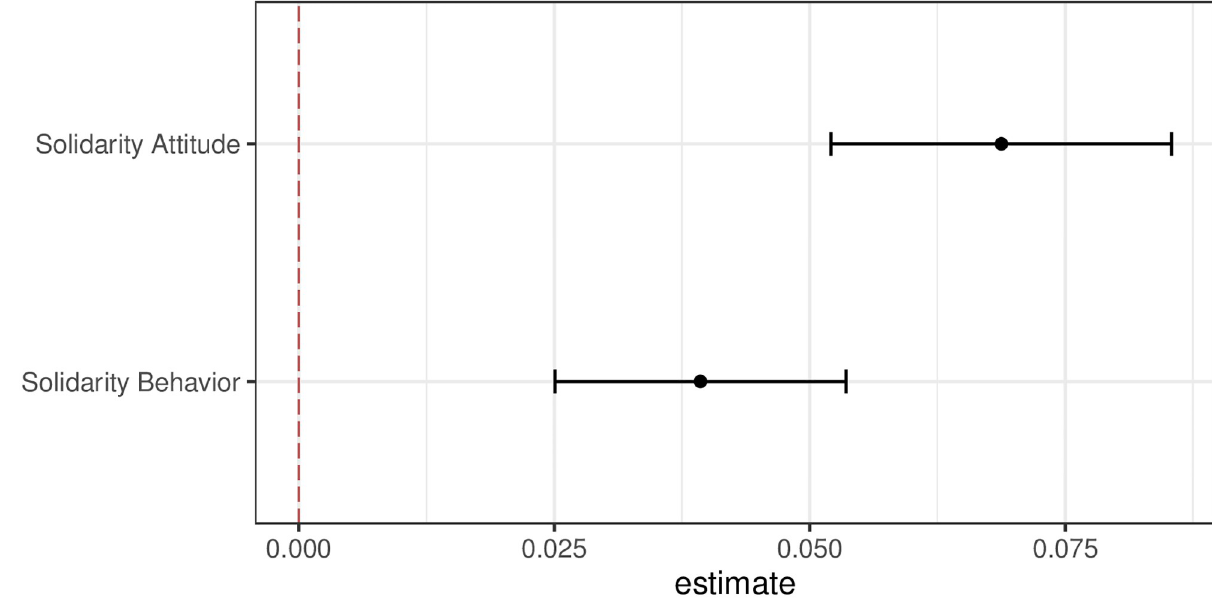
Fig 3. Effect of video treatment on individual